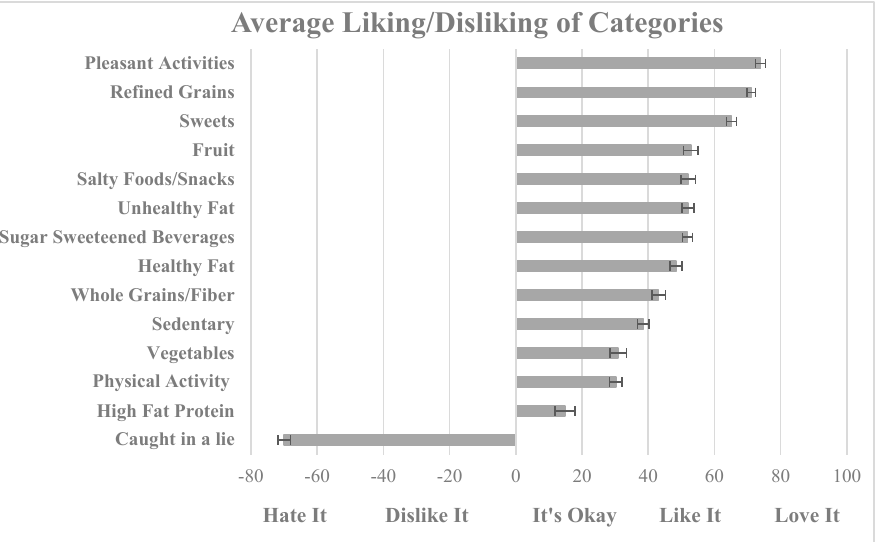
Figure 1. Average reported liking/disliking of foods and activities ranked most to least in young adult college women ( n = 189). Knowledge Scores: Figure 2 displays the variability in knowledge scores, showing a negative skewness impacted by 3 outliers (low knowledge scores). Examination of the quartiles revealed that many participant’s knowledge scores ranged between 10–13 (25th– 75th quartile), suggesting an overall low variability in the sample.